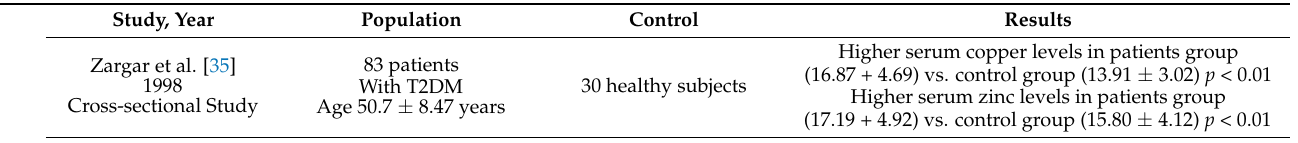
Table 4. Copper in T2DM patients. Hb, Hemoglobin. T2DM; Type 2 Diabetes